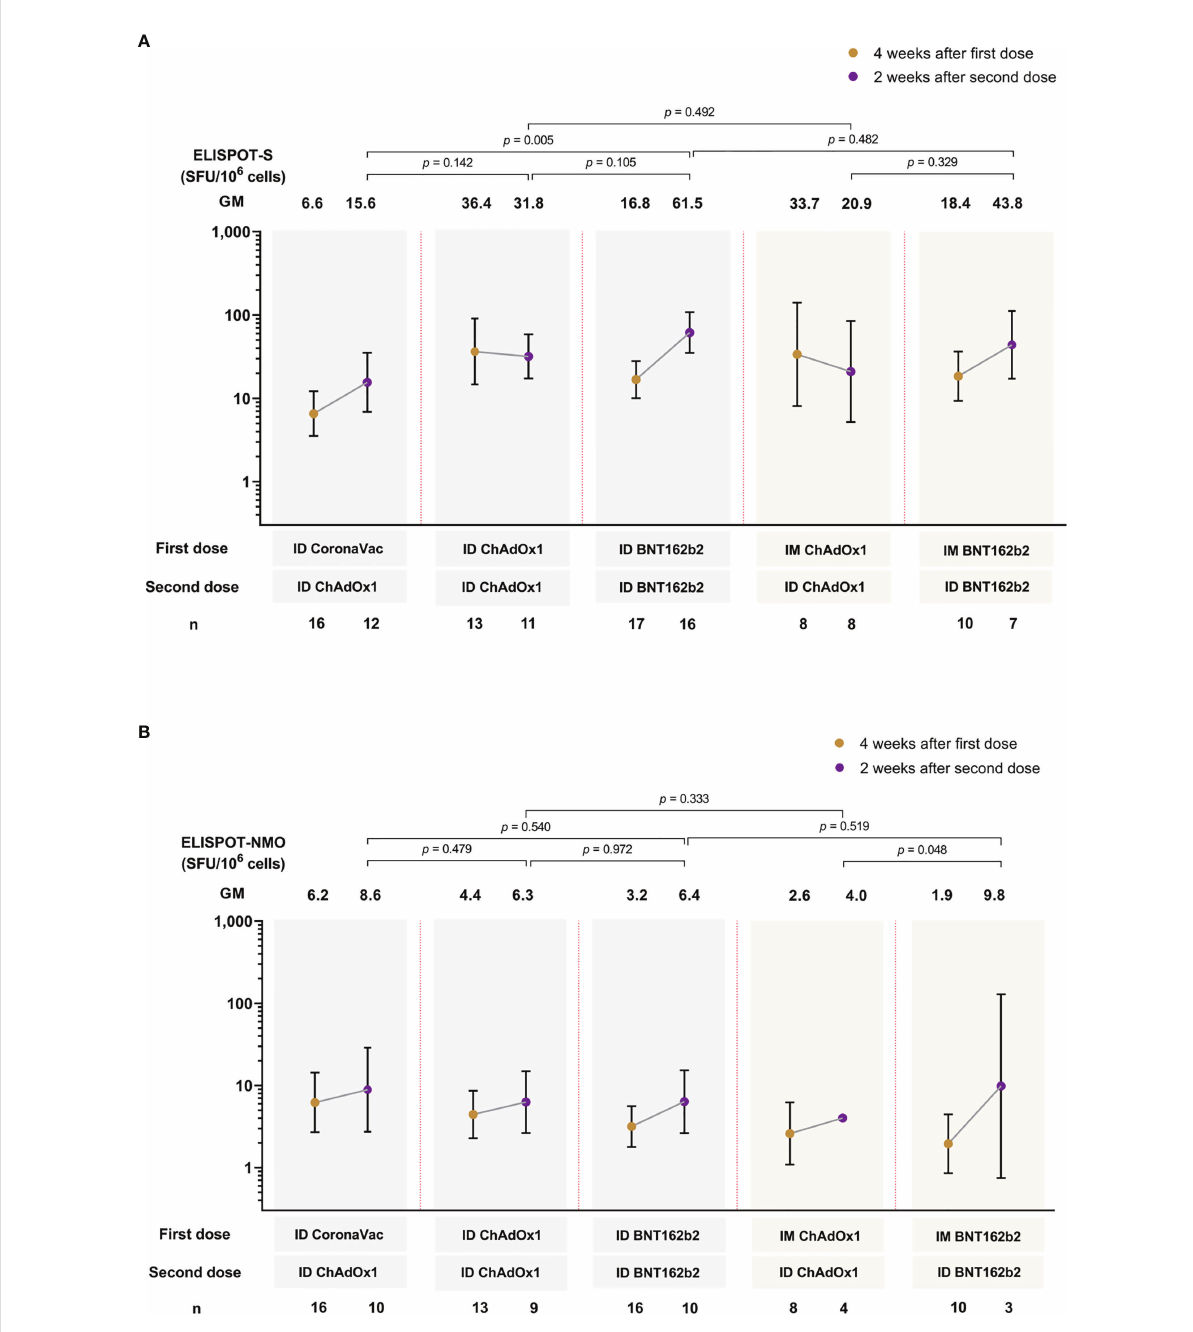
FIGURE 4 T-cell response against spike protein (A) and nucleocapsid-membrane-open reading frame (NMO) pool protein (B) of ancestral Wuhan strain measured by ELISPOT at 4 weeks and 2 weeks after fi rst and second vaccine dose, respectively. Data presented as geometric mean units (GMU) and 95% con fi dence intervals. n= number of participants. ID, intradermal; IM,